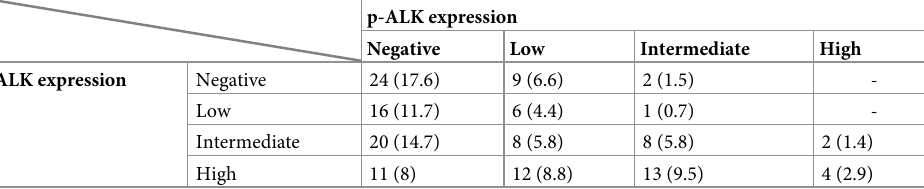
Table 2. ALK and p-ALK expression by IHC in MCC TMAs representing 136 primary tumors.